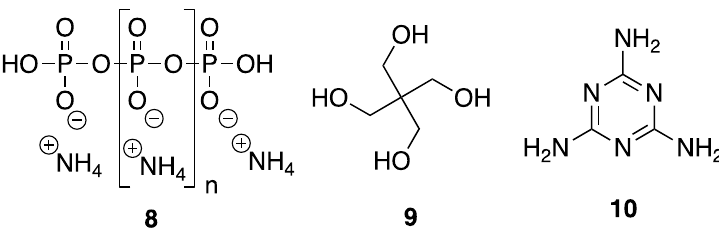
Figure 7. Chemical structures of 8 , 9 , and 10